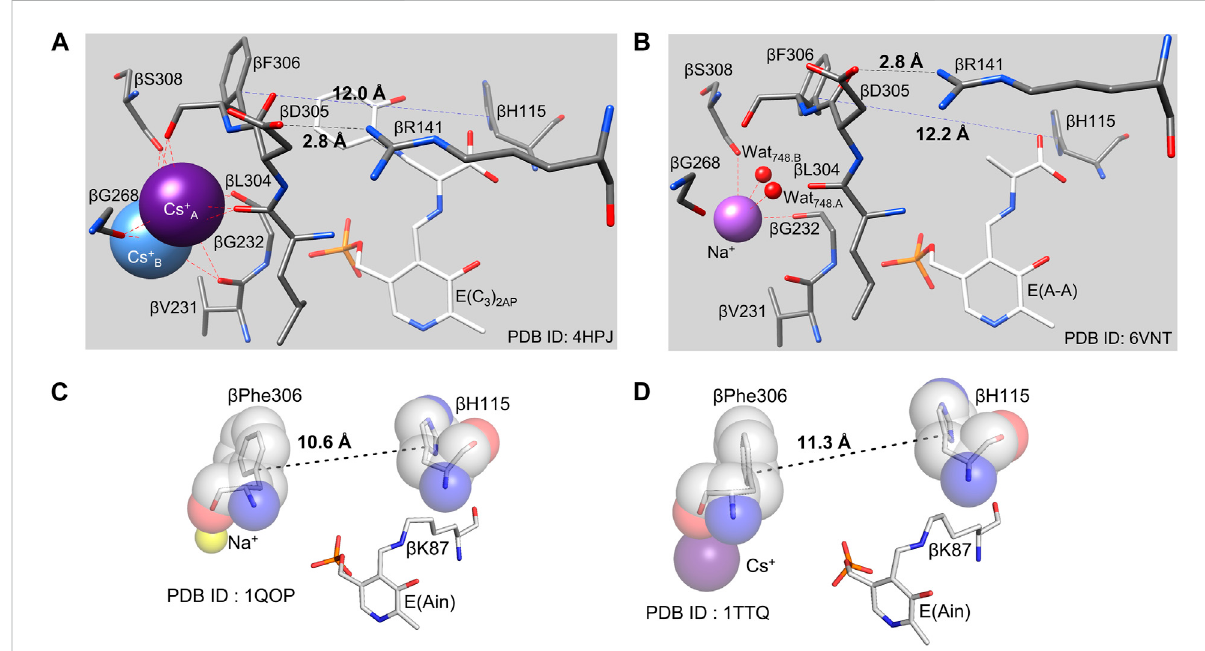
FIGURE 6 (A,B) ,Comparisonsofthepre-formedindolebindingsitesandthemonovalentcationsitesoftheE(C 3 ) 2AP (Cs + )complex (A) andtheE(A – A)(Na + ) complex (B) . The distances spanning the indole sub-site cavity betweenthe C ɣ atoms of β Phe306 and β His115 (12.0 and 12.2 Å, respectively) are just right to match the VDW surface of indole (viz., Figure 5). In the E(Ain) monovalent cation complex with Na + (C) , the subsite distance between β Phe306 and β H115 is 10.6 Å and is too small to accommodate indole. In the E(Ain)Cs + complex (D) , the β Phe306 and β H115 distance is only slightly too small. (PDB IDs: 4HPJ, 6VNT, 1QOP and